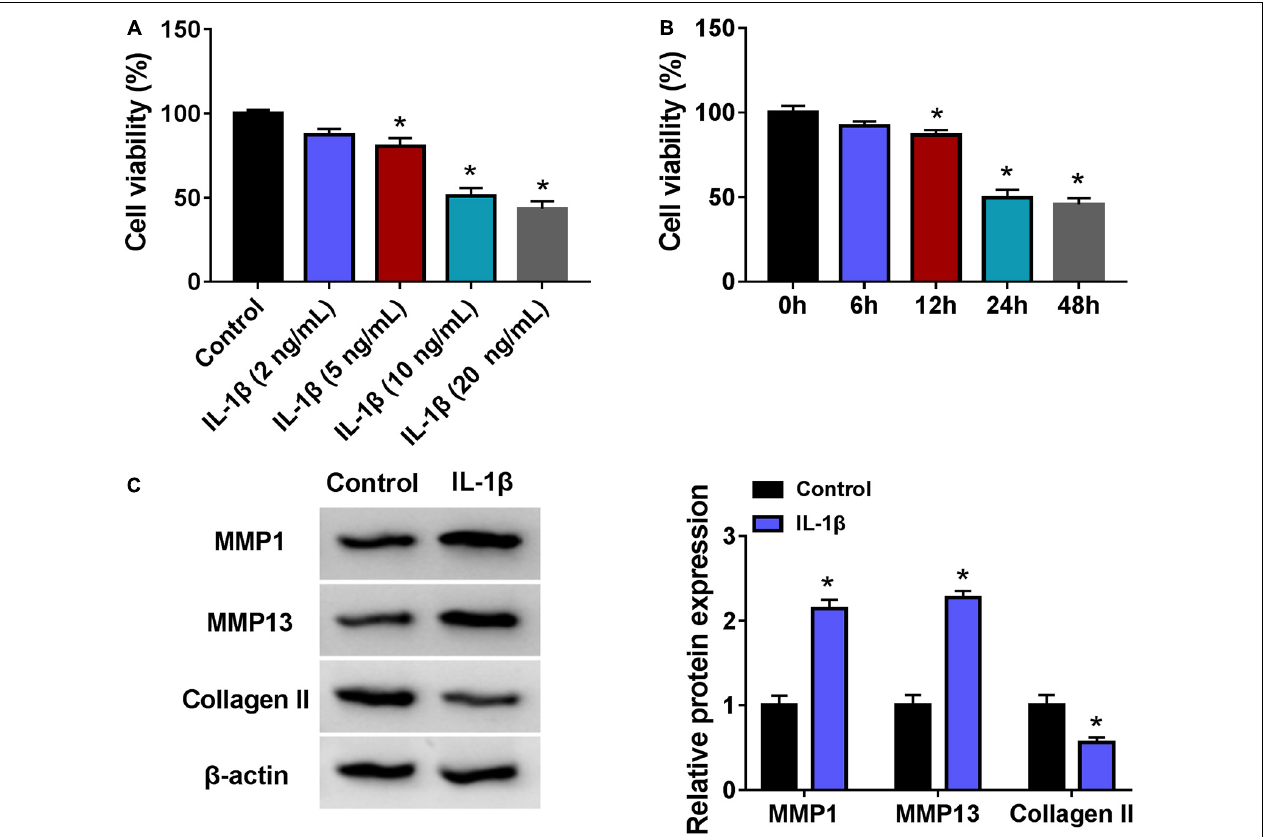
FIGURE 2 | Interleukin-1 β (IL-1 β ) induced OA model in human chondrocytes. (A,B) Cell counting kit (CCK-8) assay measured cell viability (%) of CHON-001 cells treated with (A) different concentrations of IL-1 β and (B) 10 ng/ml of IL-1 β for different times. (C) Western blotting examined relative protein expression of matrix metalloproteinase-1 (MMP1), MMP13, and Collagen II in CHON-001 cells with and without 10 ng/ml of IL-1 β treatment for 24 h. * P < 0.05 was determined by ordinary one-way ANOVA or two-way ANOVA.